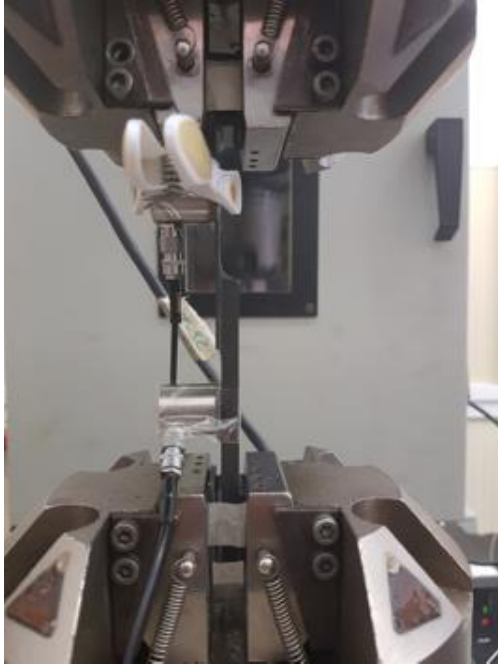
Figure 3. Testing rig with acoustic emission (AE) sensors mounted on the specimen.